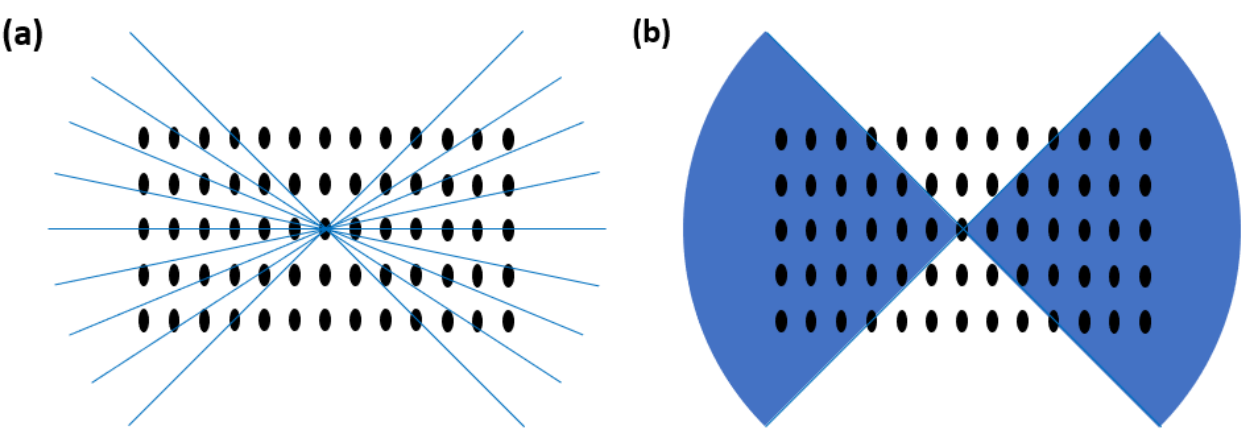
Figure 1. Illustration of ( a ) stepwise and ( b ) continuous rotation methods for three-dimensional electron diffraction (3DED) data collection. For stepwise rotation in ( a ), the crystal can be centered at each step. Fine steps are required in order to sample the reciprocal lattice and accurately estimate the intensities. For continuous rotation in ( b ), integrated intensities are obtained which are more accurate than stepwise rotation. Continuous rotation prefers detectors with a short readout time to avoid missing data during the detector readout.